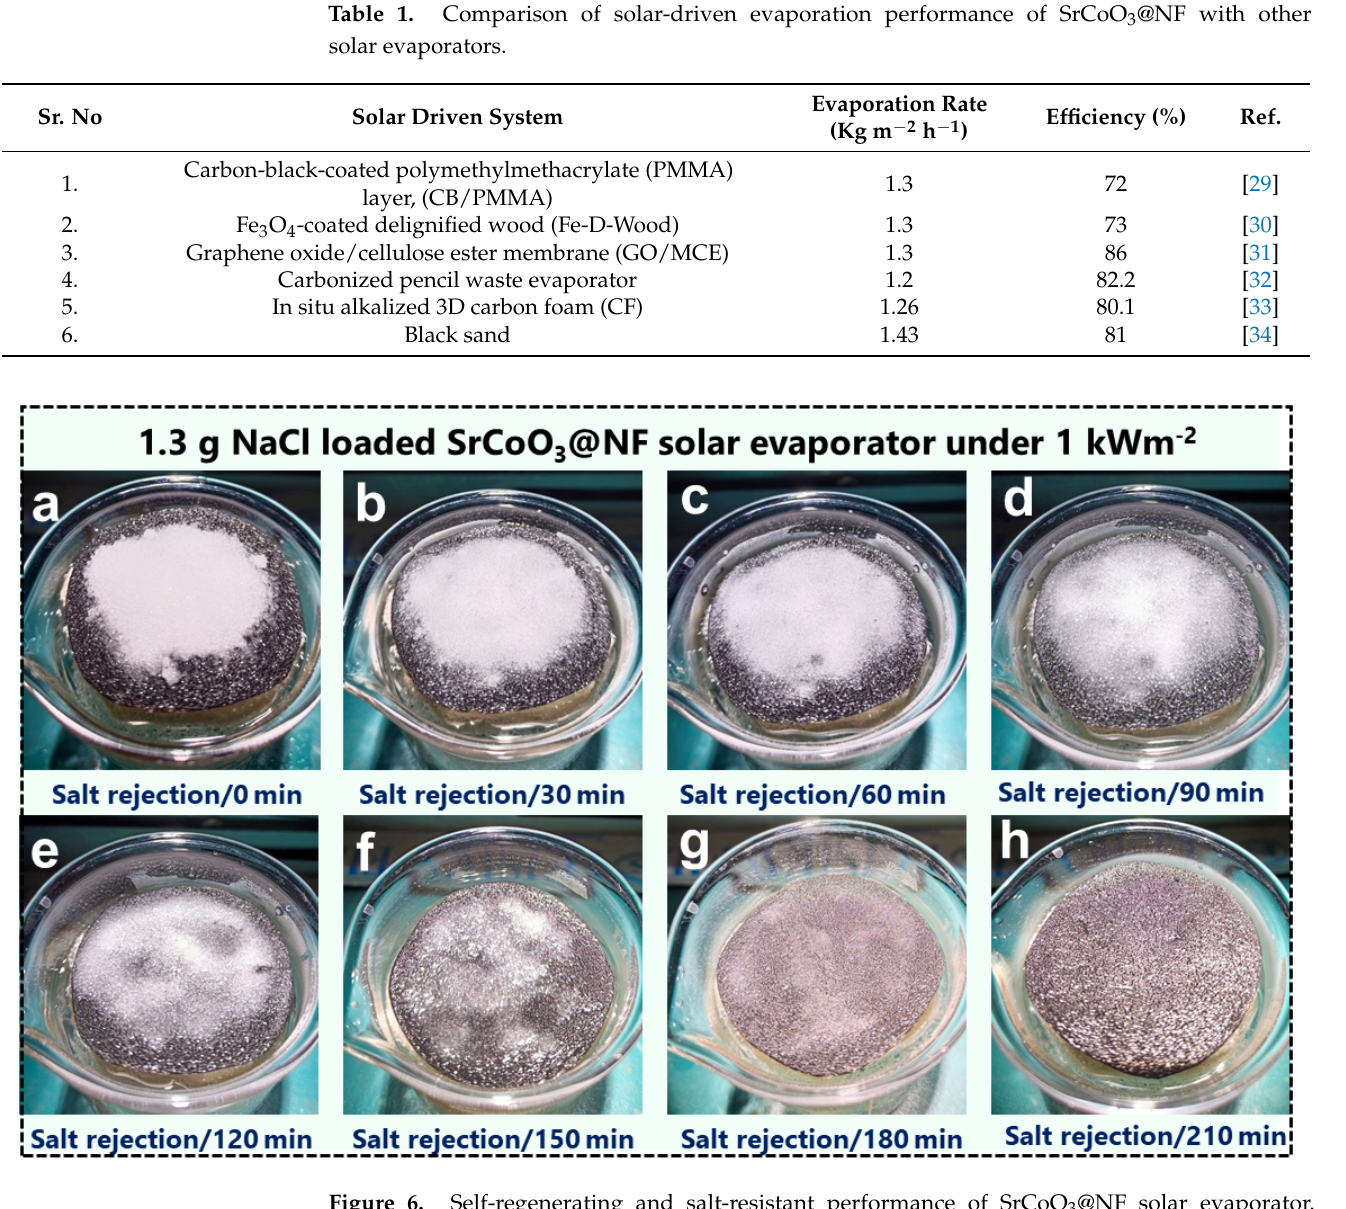
Figure 6. Self-regenerating and salt-resistant performance of SrCoO 3 @NF solar evaporator. ( a – h ) Solid NaCl powder (1.3 g) was placed on the top surface of the SrCoO 3 @NF solar evaporator and dissolved in an open porous assembly within 210 min. under 1 kW m − 2 solar intensity